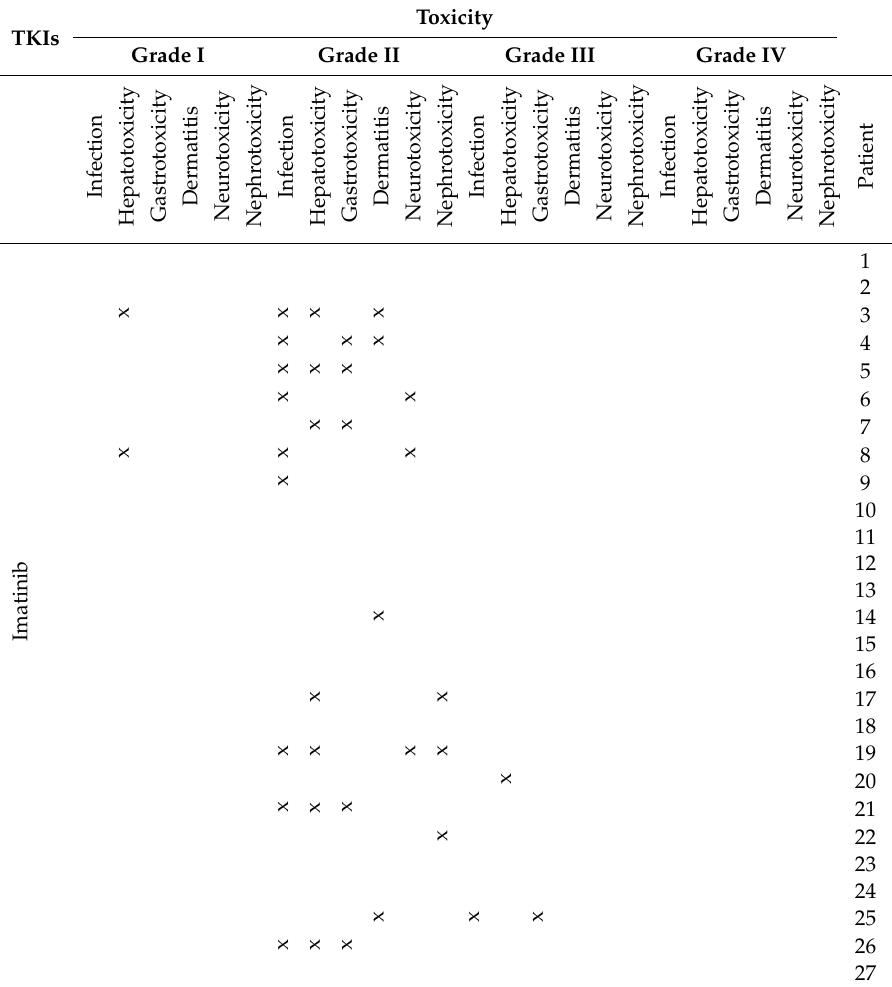
Table 2. The grade of the toxicity for each patient. TKIs: tyrosine kinase inhibitors. TKIs